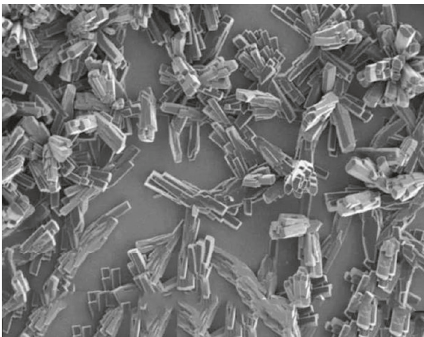
Figure 1: The microstructure of aluminum-silicon composites of different sizes after extrusion heat treatment (picture source: http://